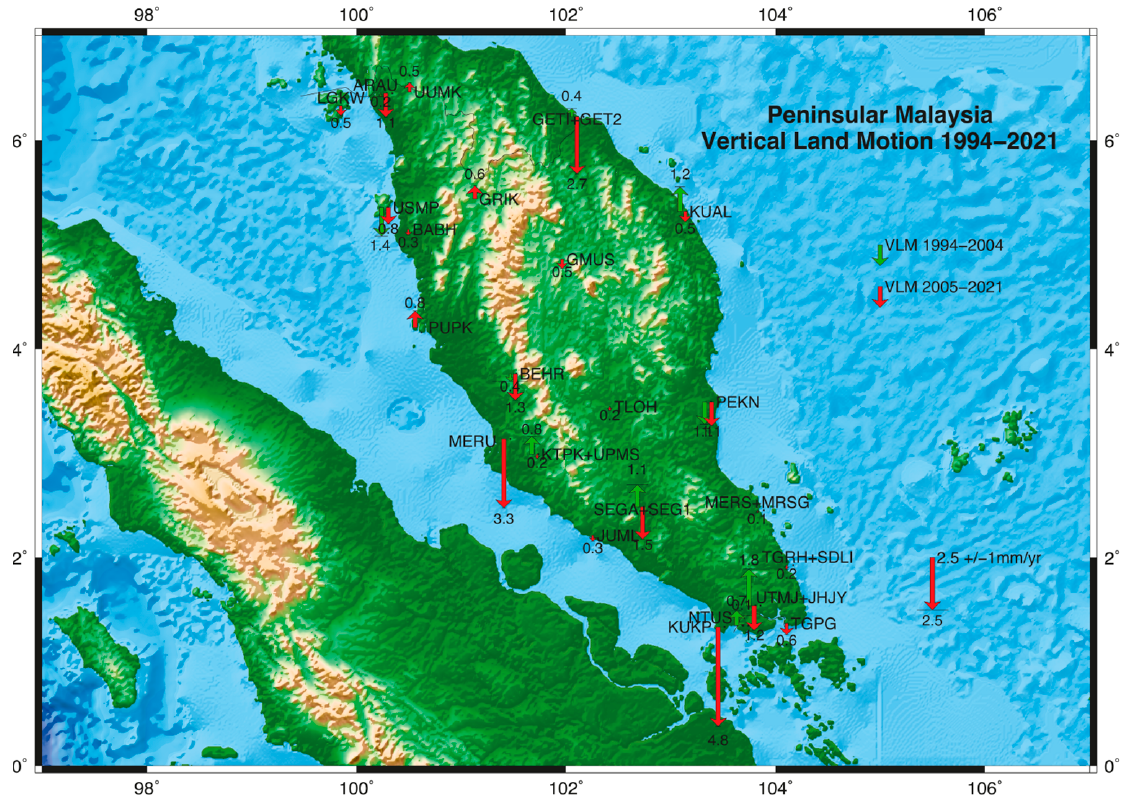
Figure 11. Vertical land motion estimates (1994–2021) in Peninsular Malaysia/Singapore. The estimates based on (split) trends (<2005 (green arrows) and >2005 (red arrows)) are shown for sites that were operational before 2005. The vertical land motion error estimates are given at a 95% confidence level. The y -axis is the latitude (N) and the x -axis is the longitude (E), both given in degrees.